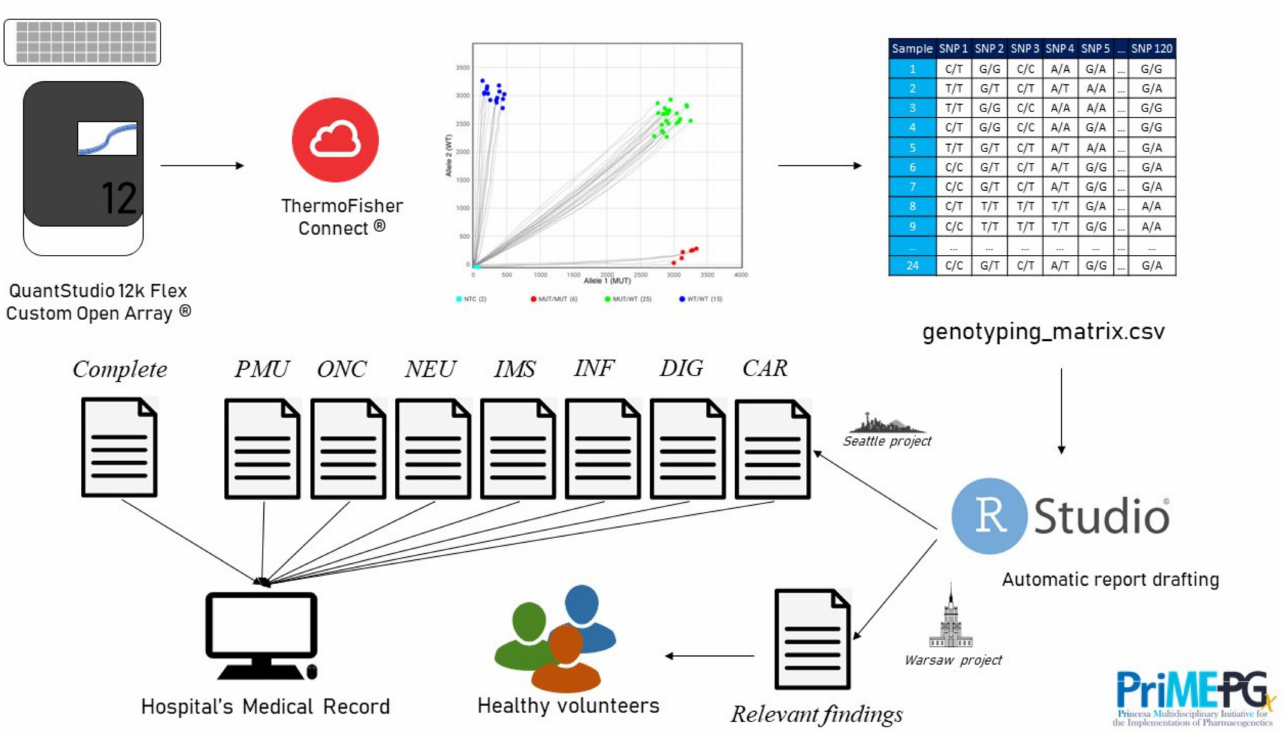
Figure 2. Laboratory workflow for the automatic generation of the different pharmacogenetic reports involved in the PROFILE and GENOTRIAL